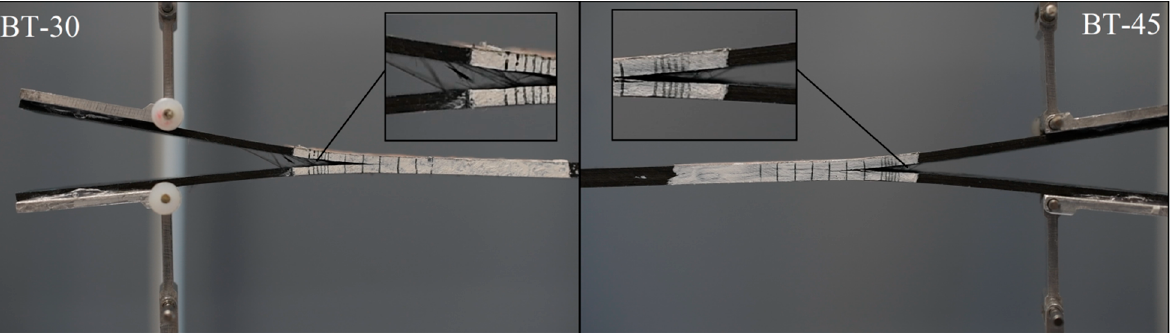
Figure 9. Fiber bridging phenomenon observed during DCB experiments conducted on the BT30 and the BT45 laminates.